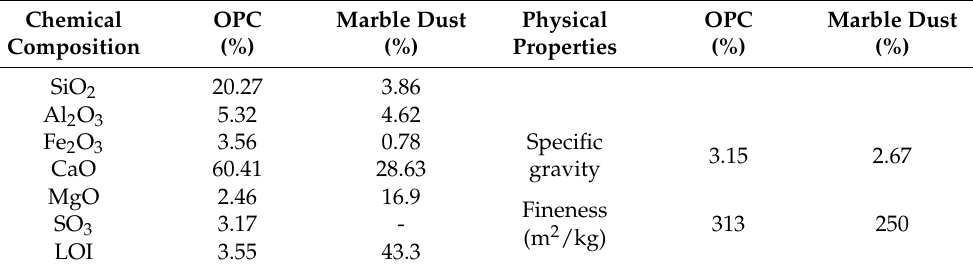
Table 1. Physical and chemical properties of cement and marble dust.